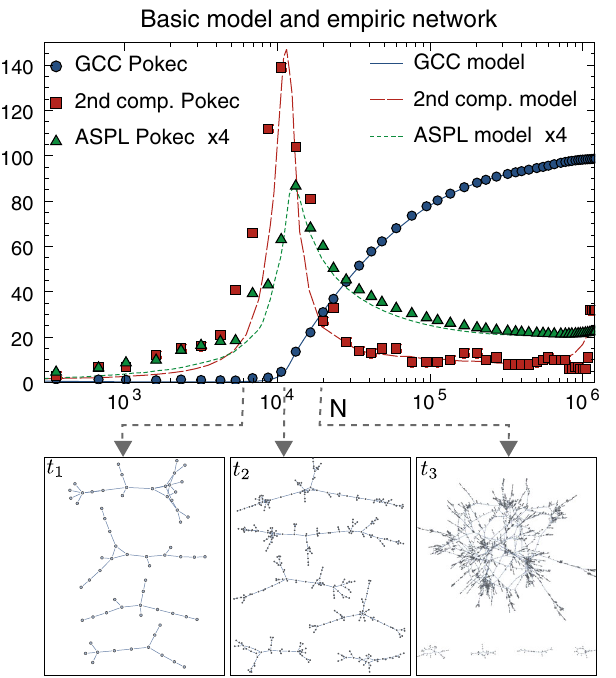
FIG. 4. Comparison of model and Pokec network evolution. Top: The symbols represent the empirical data, whereas the solid lines correspond to the results from the model averaged over 100 realizations with λ ¼ 0 . 03 and μ ¼ 0 . 008 . Points correspond to the empiric network and lines represent the results from the model. Bottom: Snapshots of the topology of the model at different times, similar to Fig. 1.